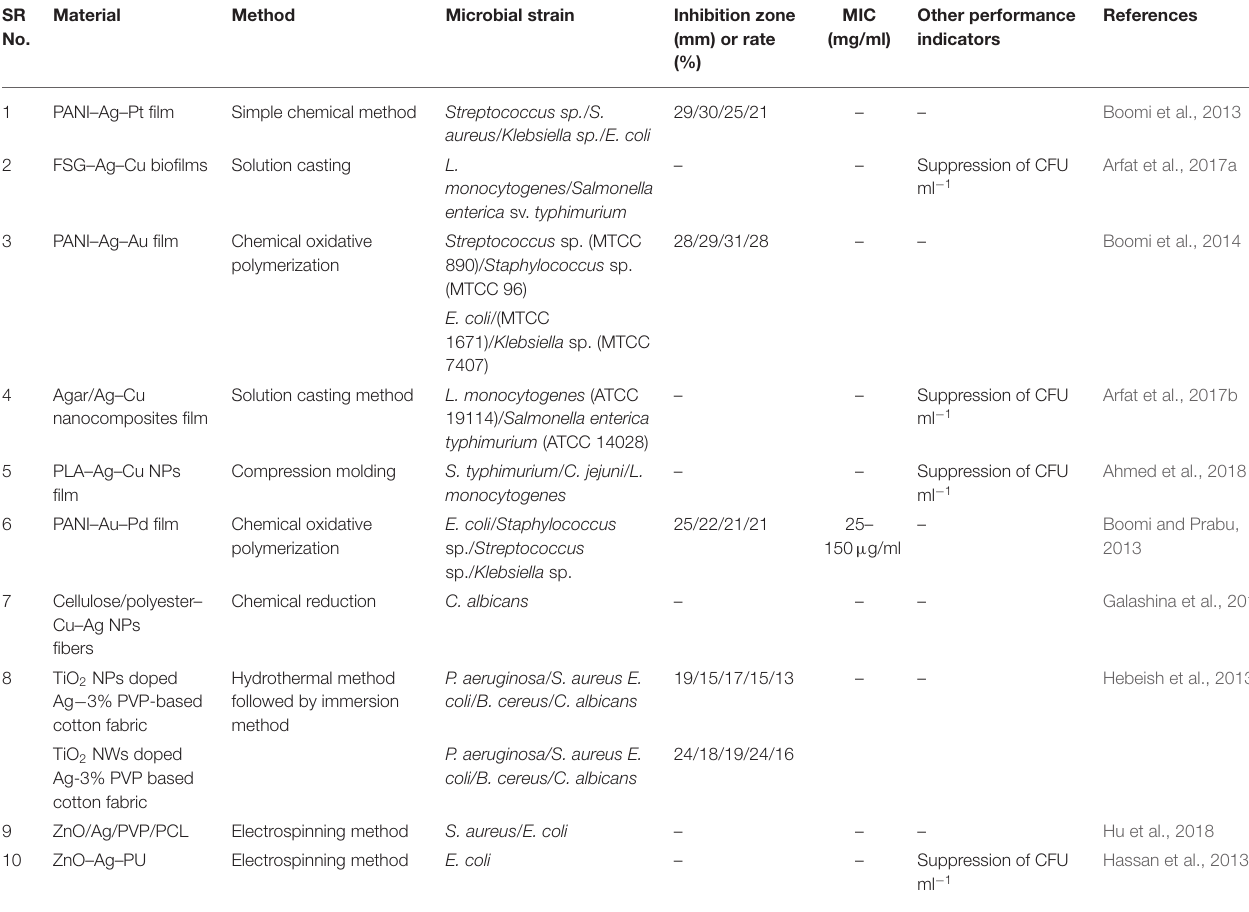
TABLE 4 | Types and antimicrobial properties of polymer-supported bimetallic nanoparticles. SR No.